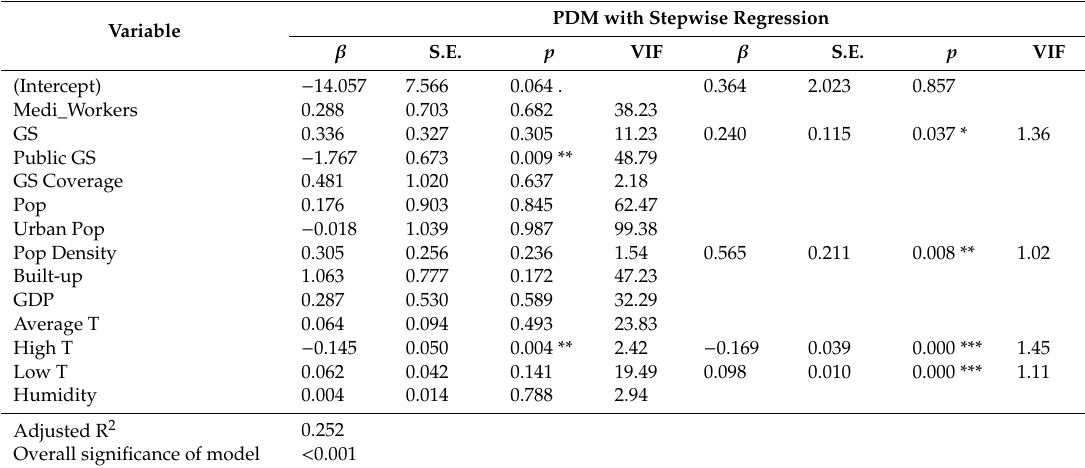
Table 7. Results of PDM of Malaria.